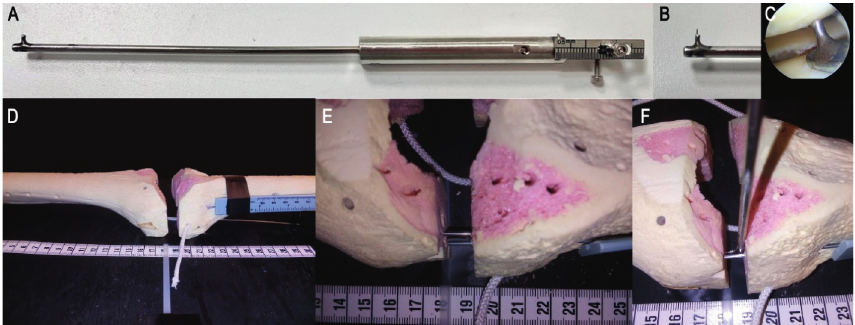
Figure 2: Custom instrument to measure the tibiofemoral joint space width using osseous phantoms for practicing. (a) Custom instrument. (b) Distal end of the instrument. (c) Arthroscopic measurement after debridement of a patient. (d) Setup for custom instrument analysis. A Kirschner wire linked the tibia to the femur, controlling the vertical tibial displacement. (e) A Vernier caliper was introduced vertically into the tibial phantom to measure different joint space widths. (f) Custom instrument used to measure the tibiofemoral joint space width, while the Vernier caliper also measures the same width for the Bland–Altman and test-retest analyses.